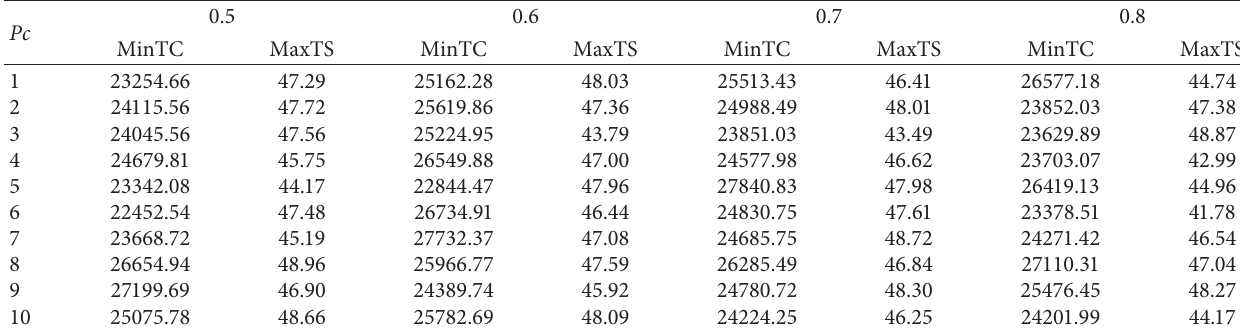
Table 4: Operating results of different crossover probabilities Pm � 0.1, NP � 300, and NG �